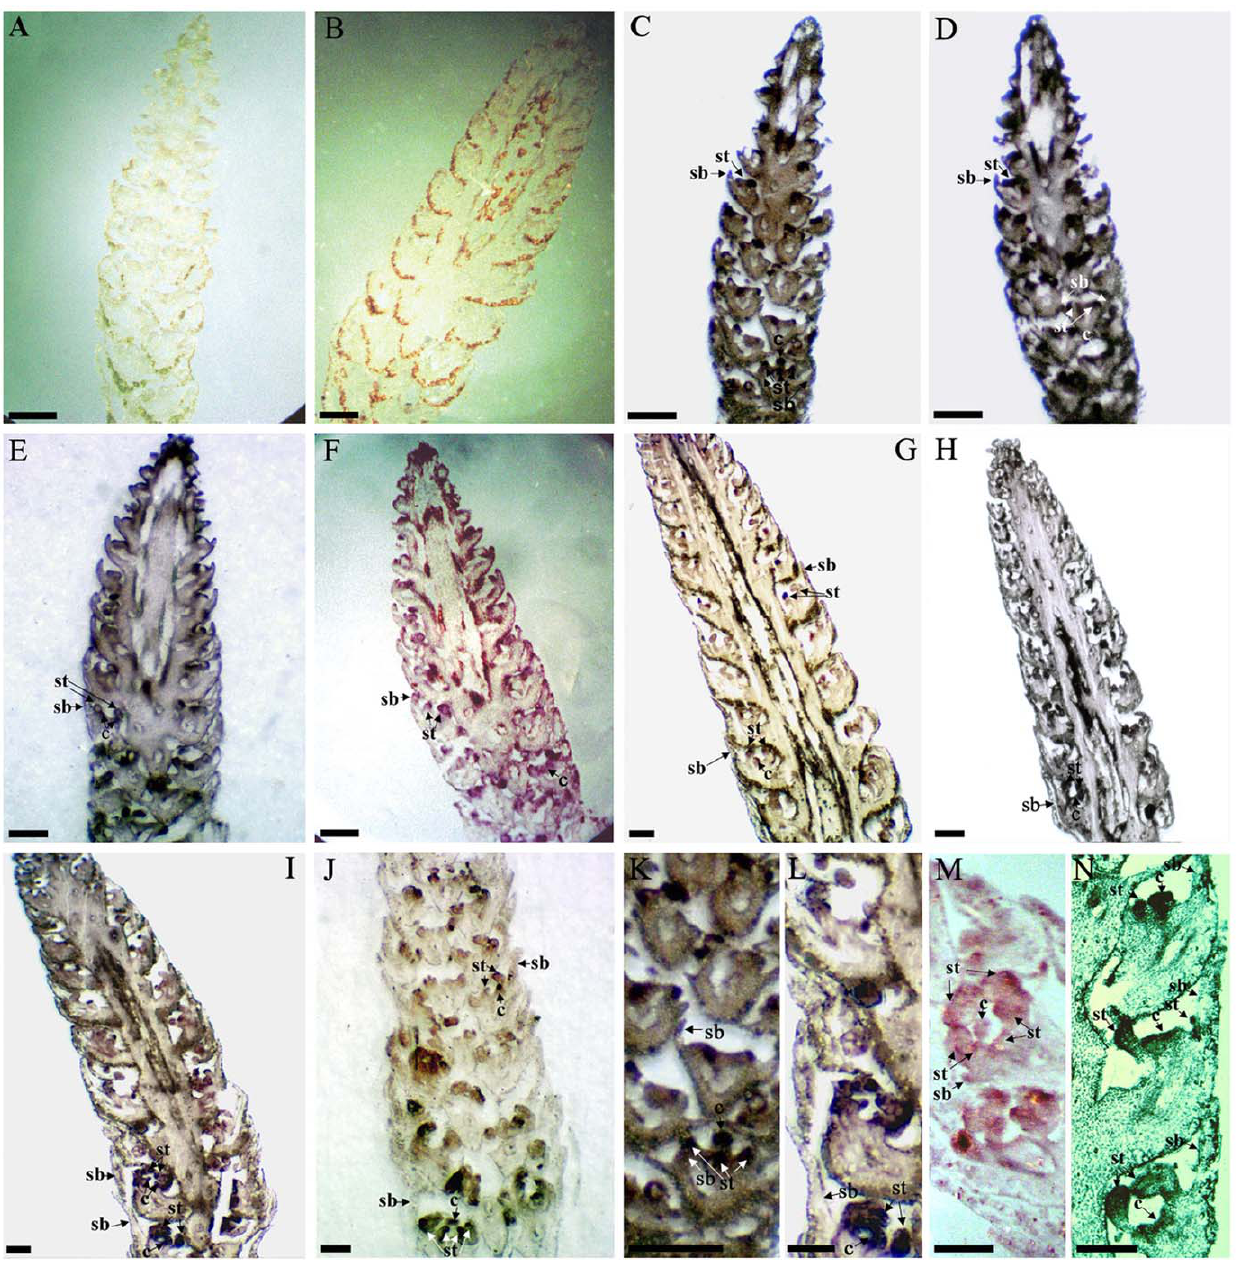
Figure 4. In-situ hybridization analysis of EH662329 ( ScAP3-B ) and EG530711 ( ScPI-B ) in longitudinal sections of developing S. chinensis inflorescences. (A and B) In-situ hybridization with EH662329 and EG530711sense probe as negative controls, respectively. (C, E, G, I, K and L) In-situ hybridization using EH662329 anti-sense probe. (D, F, H, J, M, N) In-situ hybridization using EG530711 anti-sense probe. (C, D, K), (E, F, M), (G, H, N), and (I, J, L) represent four progressive stages in inflorescence development. sb, subtending bracts; st, stamens; c, carpels. Scale bars =500 m m.